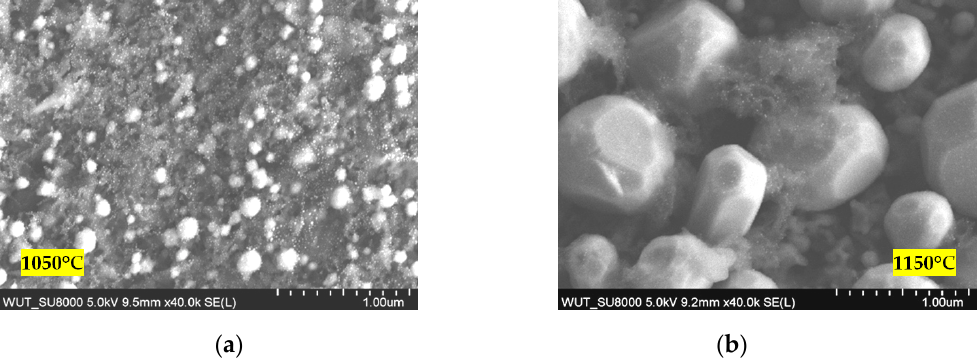
Figure 4. Morphology of the surface of the samples exposed to: ( a ) 1050 °C; ( b ) 1150 °C.